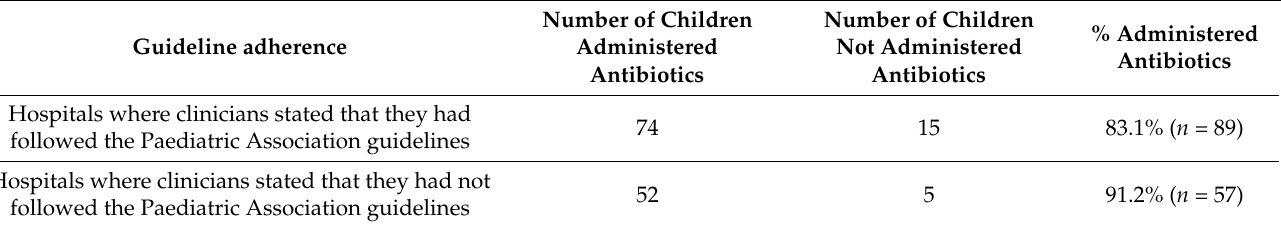
Table 5. Prescribing of antibiotics and adherence to Bangladesh Paediatric Association guidelines.